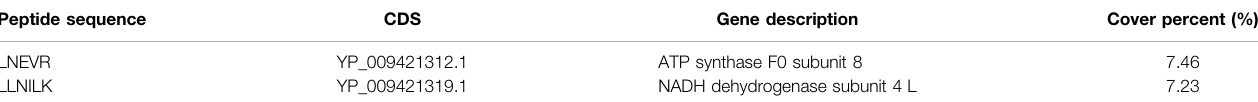
Frontiers in Pharmacology |